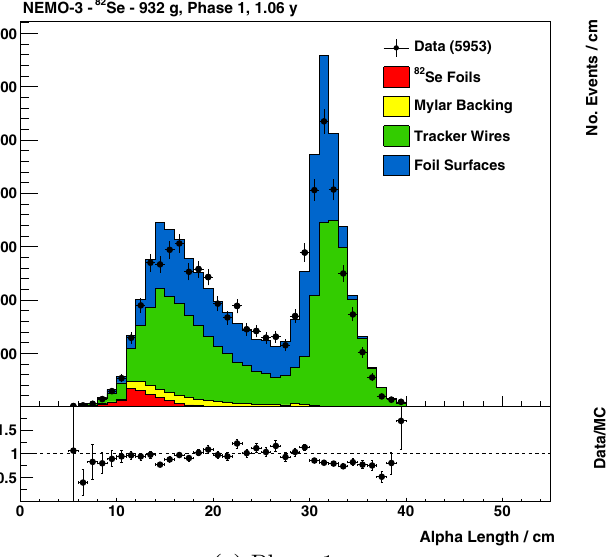
on stacked histograms of the MC prediction from 214 Bi contaminations in the source foils (red), Mylar backing film (yellow), deposits on the tracker wires (green) and on the surface of the source foils (blue). The activities of the source foil and Mylar film contaminations are the same in both phases. The bottom panels show the ratio of data to the total MC